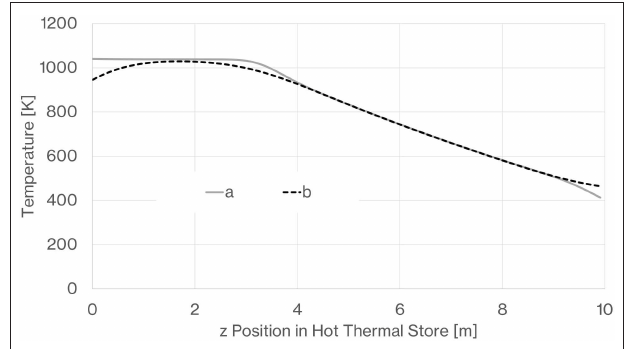
FIGURE 31 | Break even plot for the cost differential of a coupled vs. de-coupled system (a) is the extra differential CAPEX of a coupled system, (b) represents the returned value of the extra efficiency of the coupled system assuming the sale price of electricity is similar to current renewable price of £50/MWh, (c) represents the returned value of the extra efficiency of the coupled system assuming the sale price of dispatchable electricity is given a premium and becomes worth 5 times the current value of renewable electricity, i.e.,